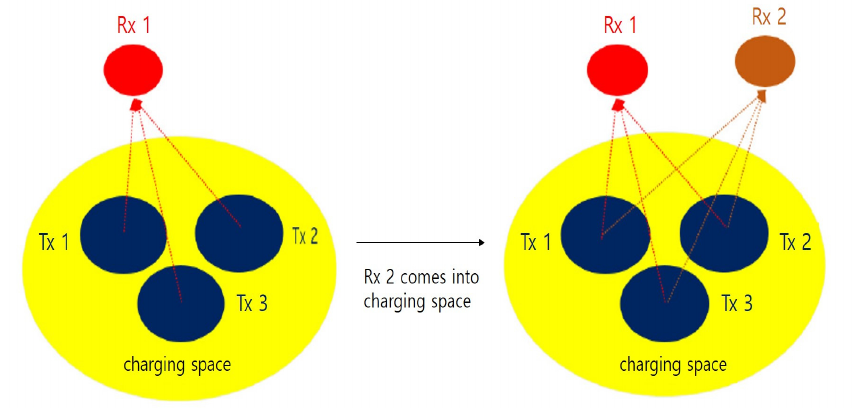
Figure 2. Proposed charging scenario. Rx 1 comes into the charging space first, then Rx 2 comes. To calculate the voltages of Tx coil, Ψ is should be known. However, it is hard to estimate the H accurately without feedback from Rx coils because Z − 1